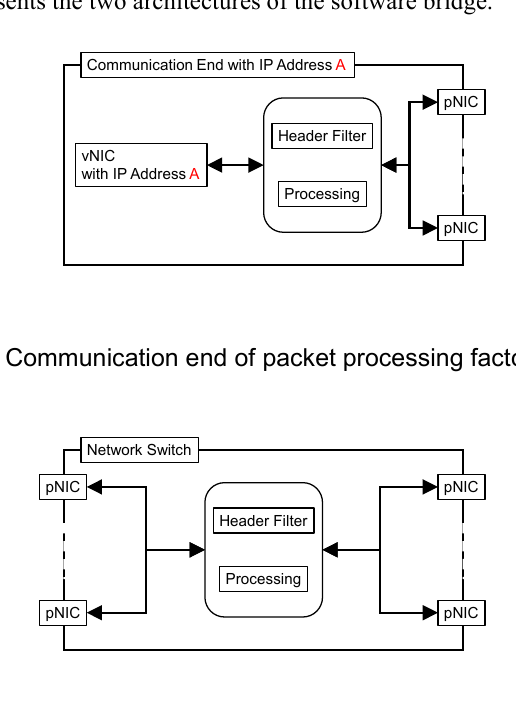
Figure 1. Two simple architectures of the packet processing